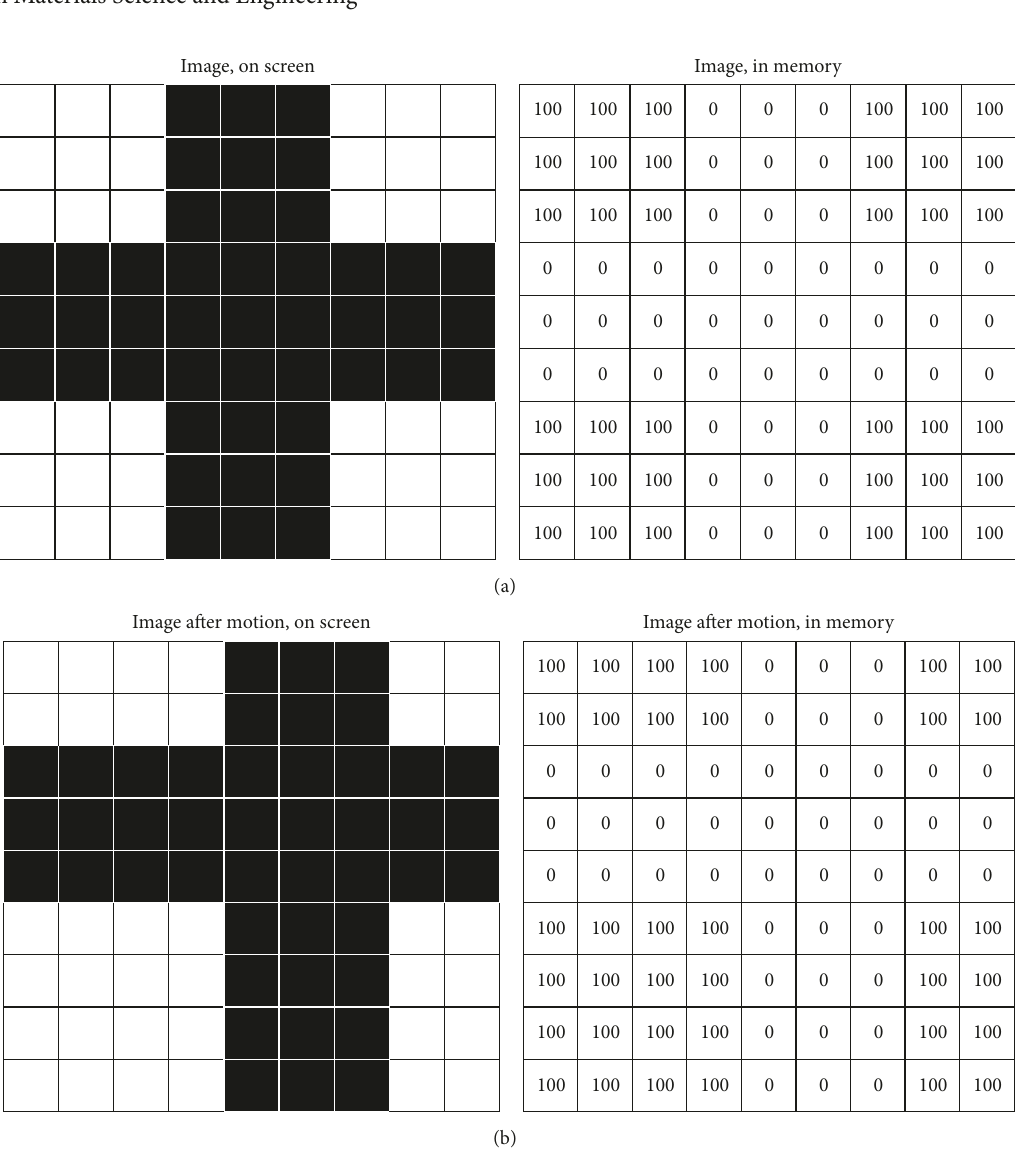
Figure 4: (a) Grayscale values (nondeformed configuration). (b) Grayscale values (deformed